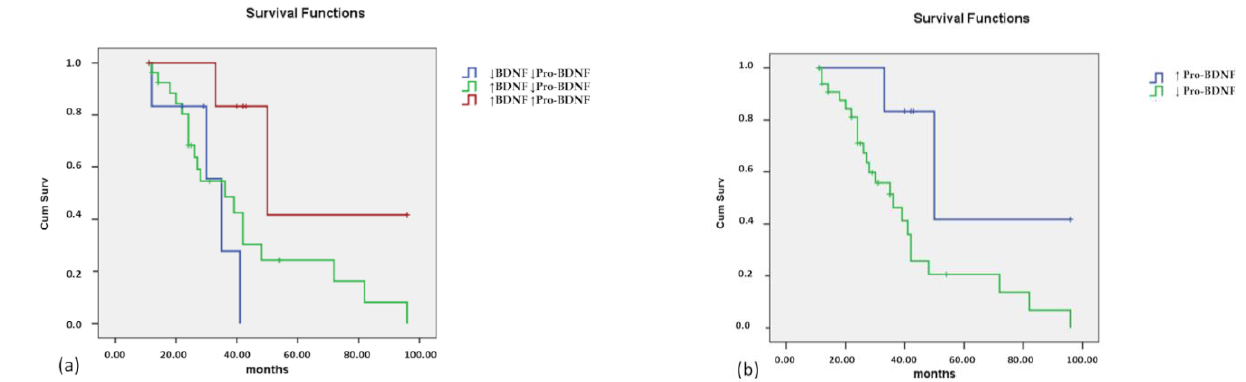
Figure 3. Kaplan-Meier survival curves in relation to BDNF and Pro-BDNF levels in patients not carrying the C9orf72 expansion. ( a ) Blue line: decrease of both BDNF and Pro-BDNF levels; green line: increased BDNF and decreased Pro-BDNF; burgundy line: increase in both BDNF and Pro-BDNF levels. ( b ) Blue line: increased Pro-BDNF levels; green line: decreased Pro-BDNF (regardless BDNF levels). Censored values (+) indicate the last known follow-up time for those subjects still alive at the time of analysis.